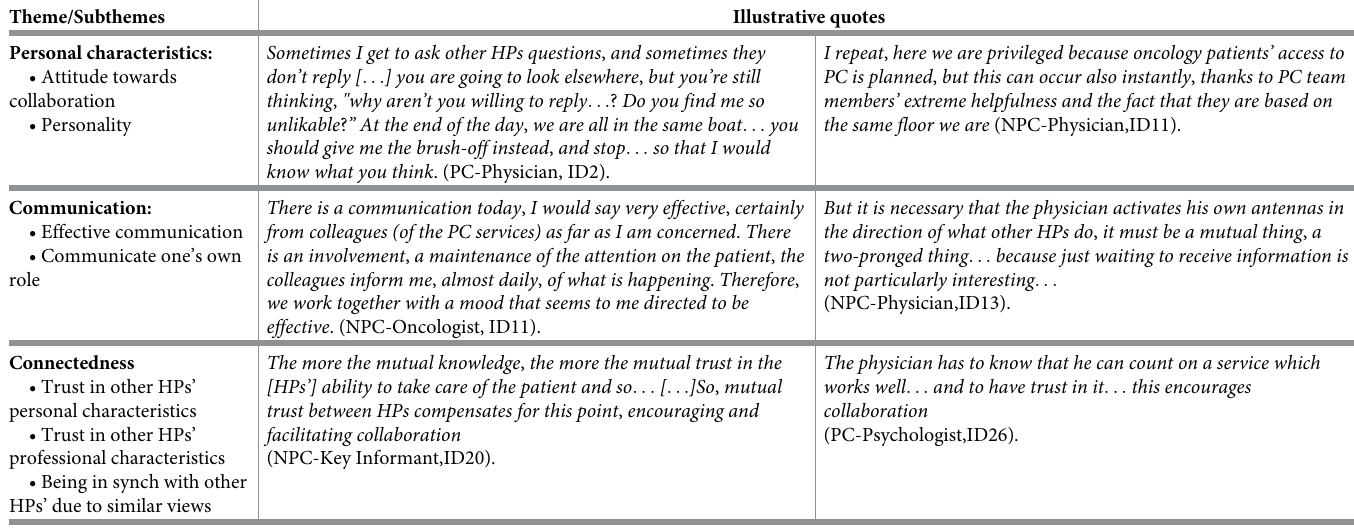
Table 3. Interactional barriers and facilitators to successful collaboration from perspectives of PC and NPC providers, patient family members, and illustrative data extracts.